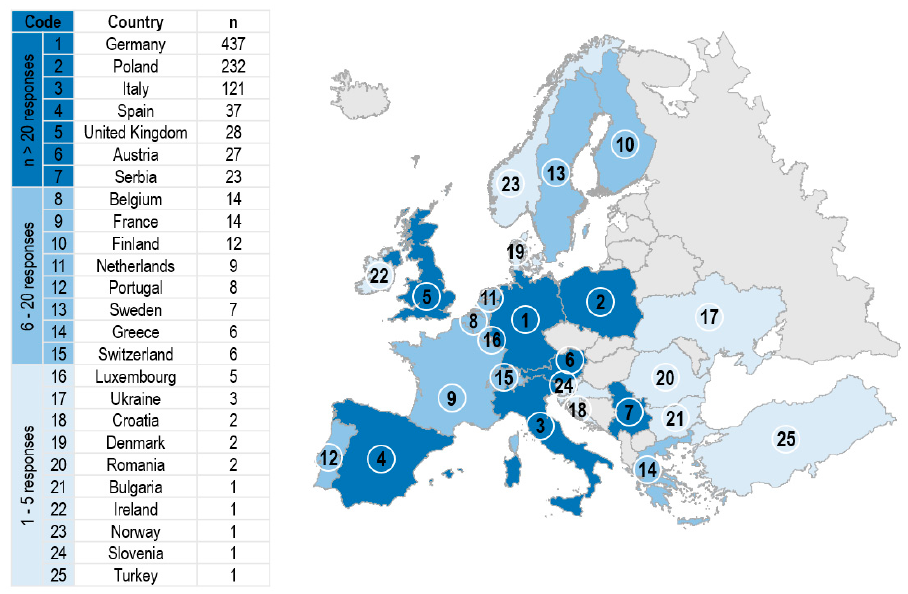
Figure 1. Location of all participating countries and number of participants per country.